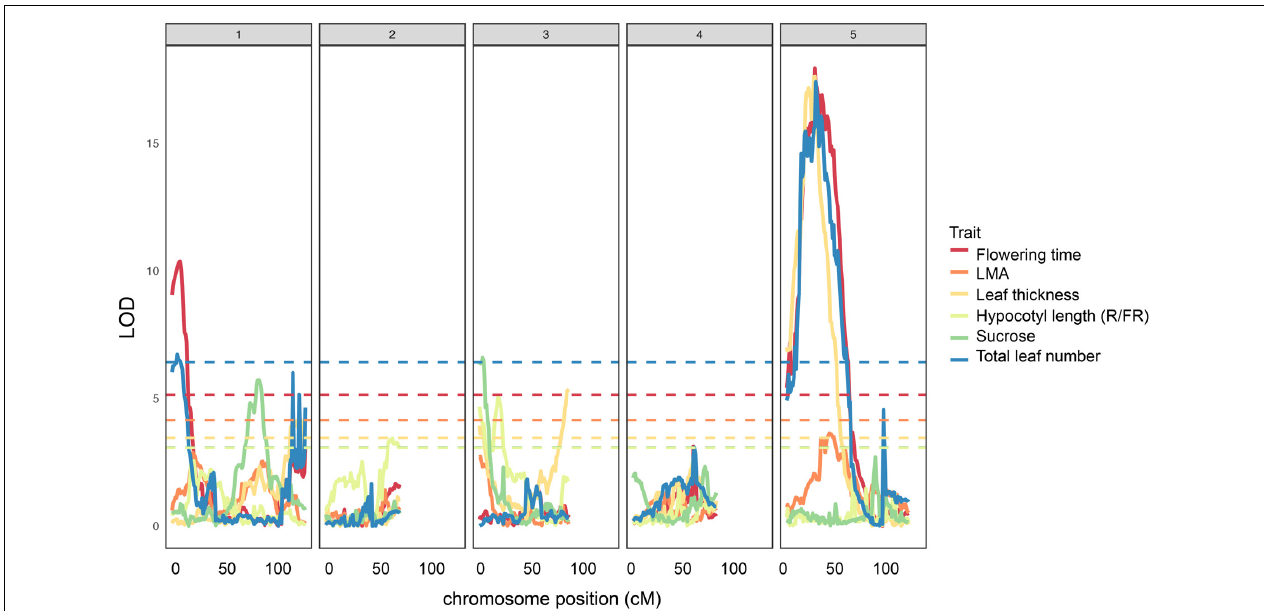
FIGURE 3 | Quantitative trait loci for leaf thickness (this study), LMA (this study), flowering time, total leaf number, sucrose content, and hypocotyl length (R/FR light) in the Ler × Cvi RILs. Horizontal dashed lines show LOD significance thresholds for each trait ( p < 0.05, 10,000